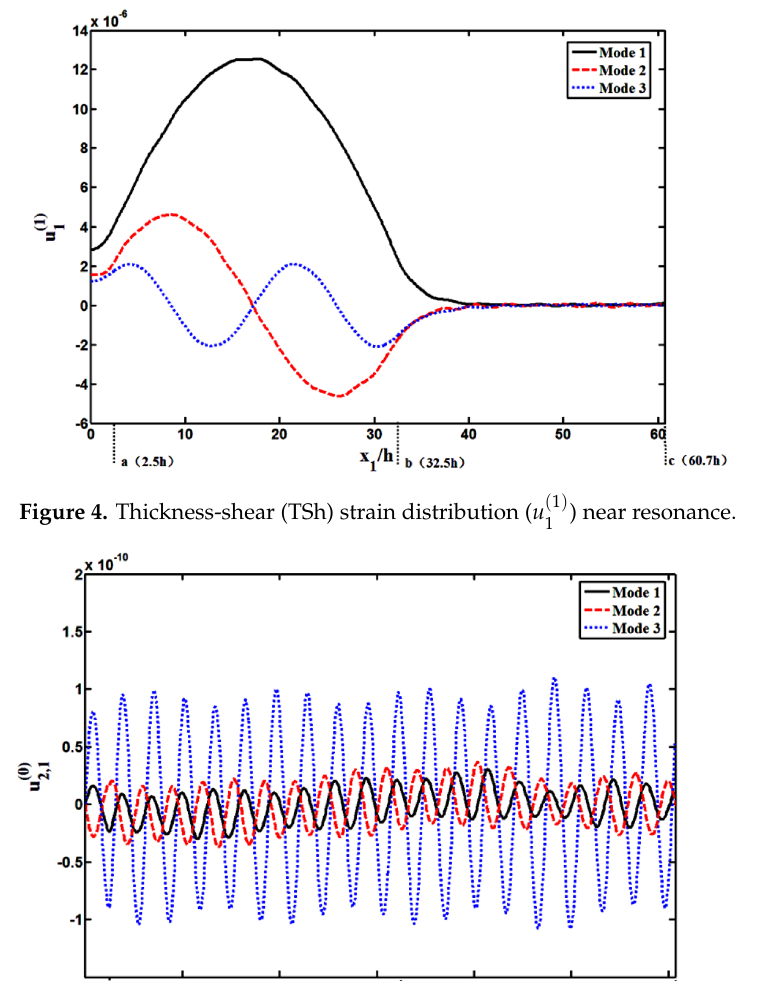
Figure 3. Normalized capacitance with respect to diving frequency showing resonance modes.